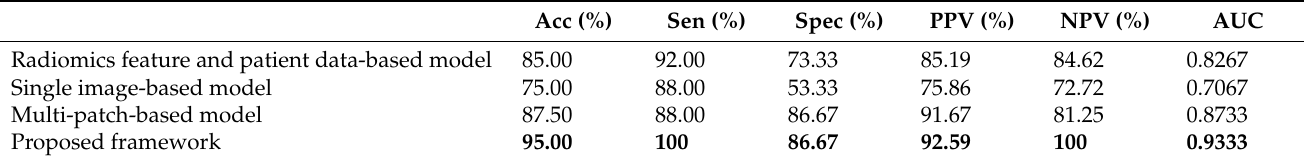
Table 6. The classification performance of different classification models.